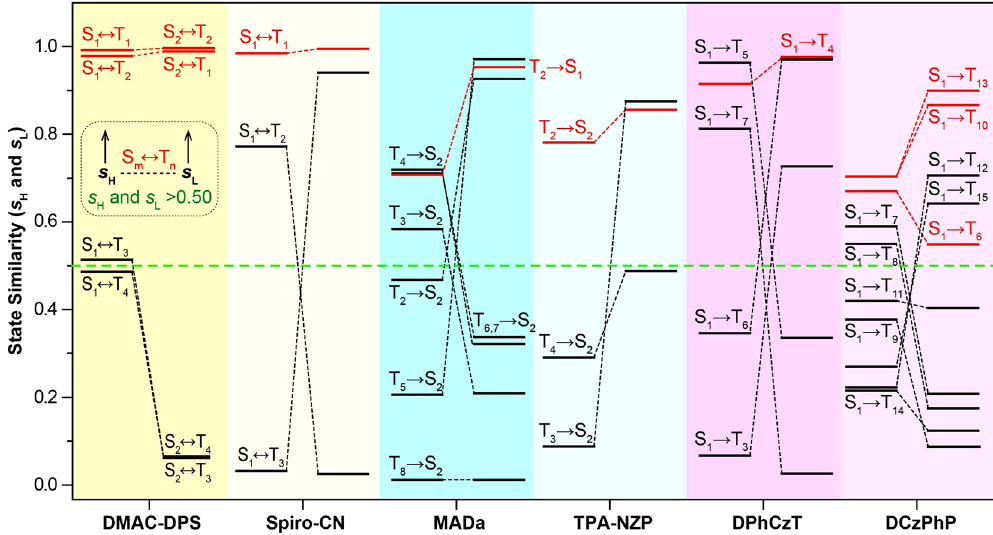
Figure 6. Similarity of HONTO ( s H , left) and LUNTO ( s L , right) between S m and T n in TADF (S m ↔ T n ), HLCT (T n → S m ), and OURTP (S 1 → T n ) molecules. The matched excited states for efficient exciton transformation that have the small energy gap (| Δ E ST | < 0.37 eV) and high state similarity ( s H and s L > 0.50) are highlighted in